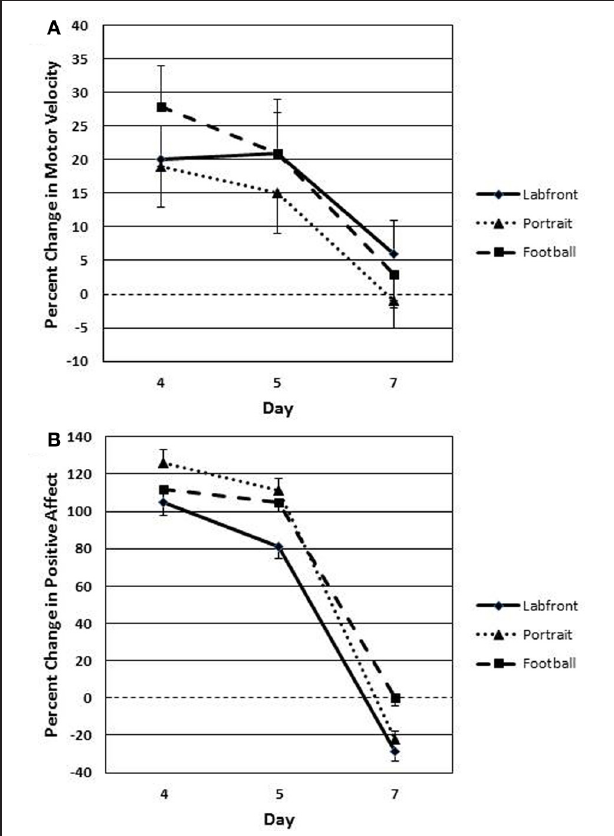
FIGURE 6 | Extinction (placebo during days 5, 6, and 7) of conditioned contextual facilitation of motor velocity (A) and positive affect (B) to successfully conditioned video clips ( Labfront , Portrait , and Football ) in PH participants (who were the only participants to condition). Degree of extinction of conditioned contextual facilitation is indexed as % change (change from day 1) in responding on Test day 4, day 5, and day 7. Responding on day 5 is a strong index of conditioning in that facilitated responding (degree of similarity to facilitated responding on Test day 4) occurs only to context, because the unconditioned effects of methylphenidate are absent. PH, paired high extraverts.